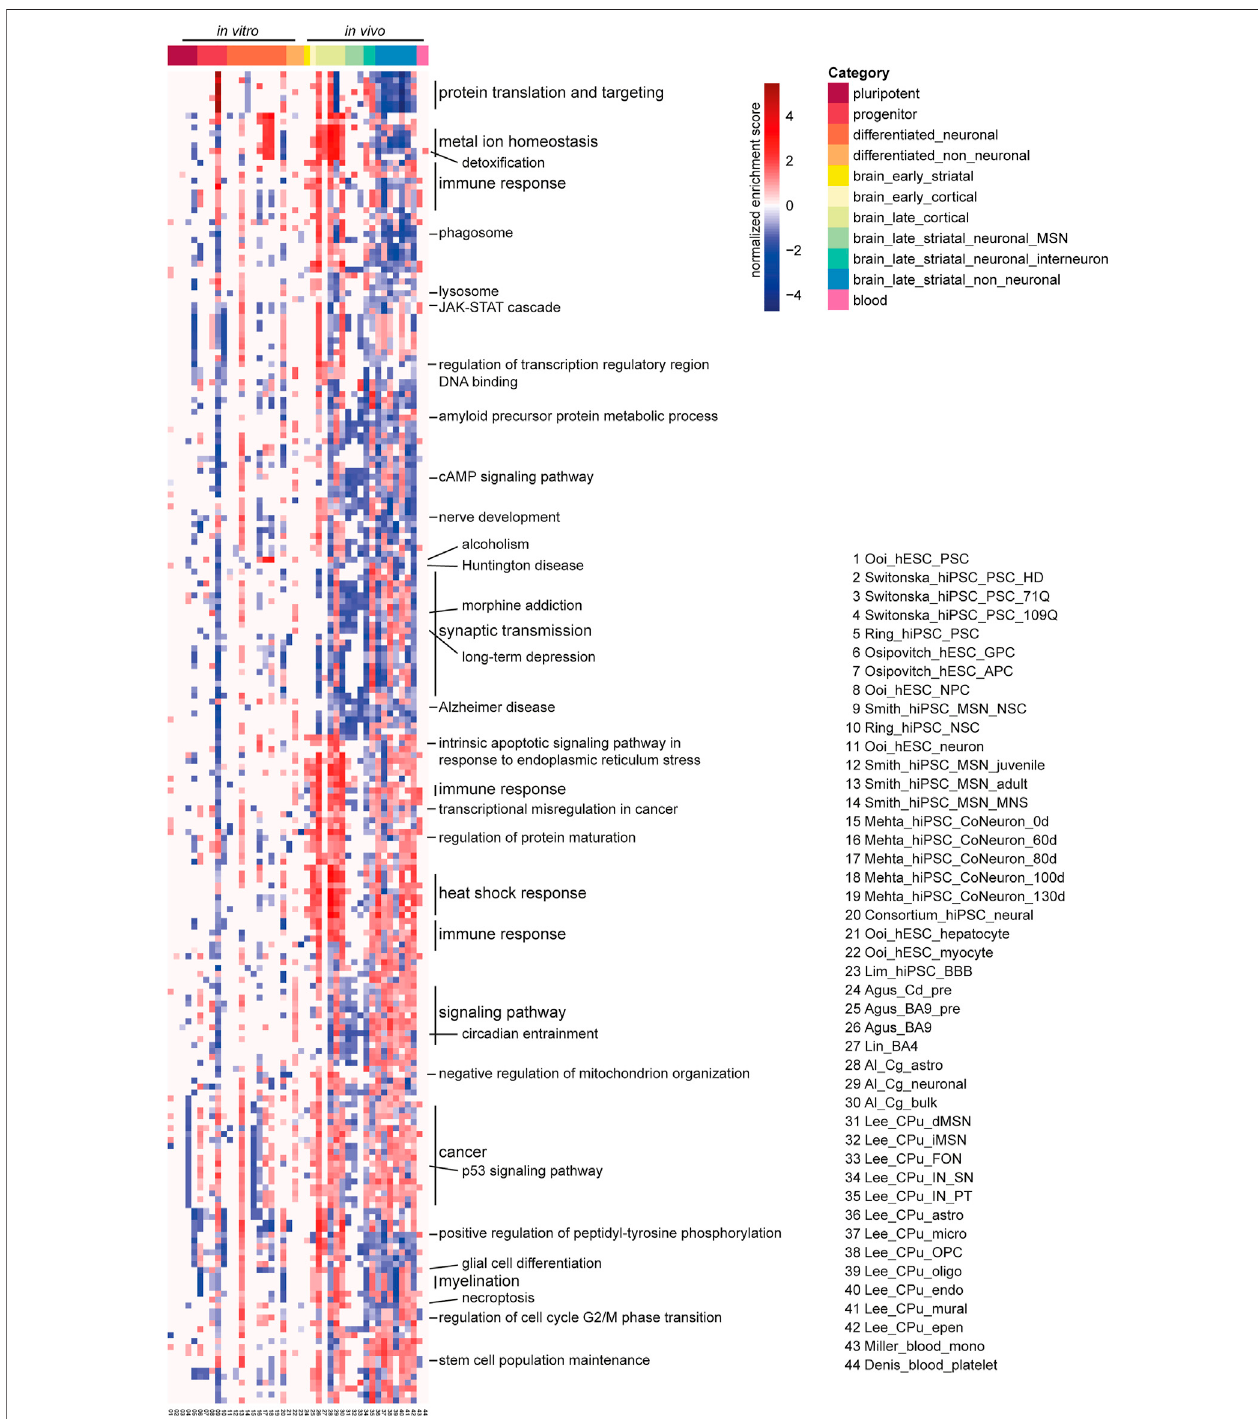
FIGURE 4 | Gene set enrichment analysis (GSEA) enrichment heatmap of 44 human HD RNA-seq datasets. Top 20 enriched gene sets for the GO biological process and KEGG pathway were combined and shown here. Each column isa human HD RNA-seq DEG dataset, each row is a gene set ofthe GO biological process or KEGG pathway. Adjacent gene sets with a common biological function are grouped and labeled as such. Red indicates positive enrichment, blue negative. Abbreviations: CPu, caudate putamen; astro, astrocyte; epen, ependymal; endo, endothelial; IN, interneuron; PT, Pvalb/Th-expressing; MSN, medium spiny neuron; MNS, MAP2+ and NES/SOX2-; OPC, oligodendrocyte progenitor cell; oligo, oligodendrocyte; micro, microglia; NSC, neural stem cell; Cg, cingulate cortex; FON, Foxp2/Olfm3-expressing neuron; SN, Sst/Npy-expressing; dSPN/iSPN, direct/indirect pathway spiny projection neuron; mono, monocyte; NPC, neural progenitor cell; CoNeuron, cortical neuron; Cd, caudate nucleus; pre, presymptomatic; GPC, glial progenitor cell; APC, astrocyte precursor cell; BBB, blood brain barrier.